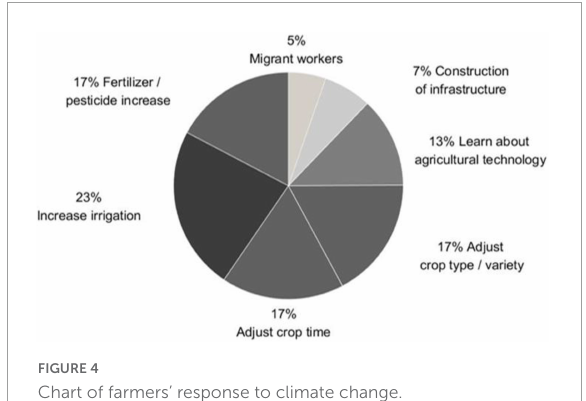
FIGURE4 Chart of farmers’ response to climate